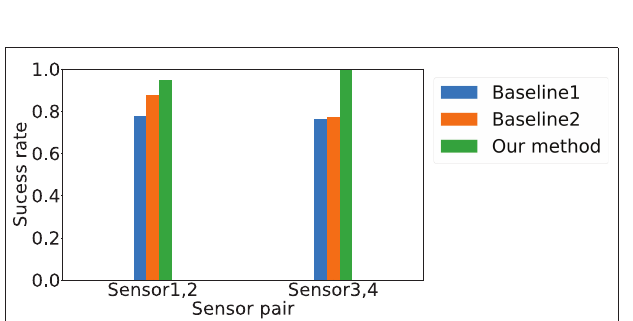
FIGURE 6 | Localization errors of sensors over different locations. The x -axis is the Sensor ID. The y -axis is the localization errors. Blue, orange, and green bars represent results from Baseline 1, Baseline 2, and our approach AutoLoc , respectively. Sensor 3 and 4 demonstrate higher localization error, which could be caused by lower vision-based footfall localization accuracy due to the farther distance between the camera and selected footfall events.